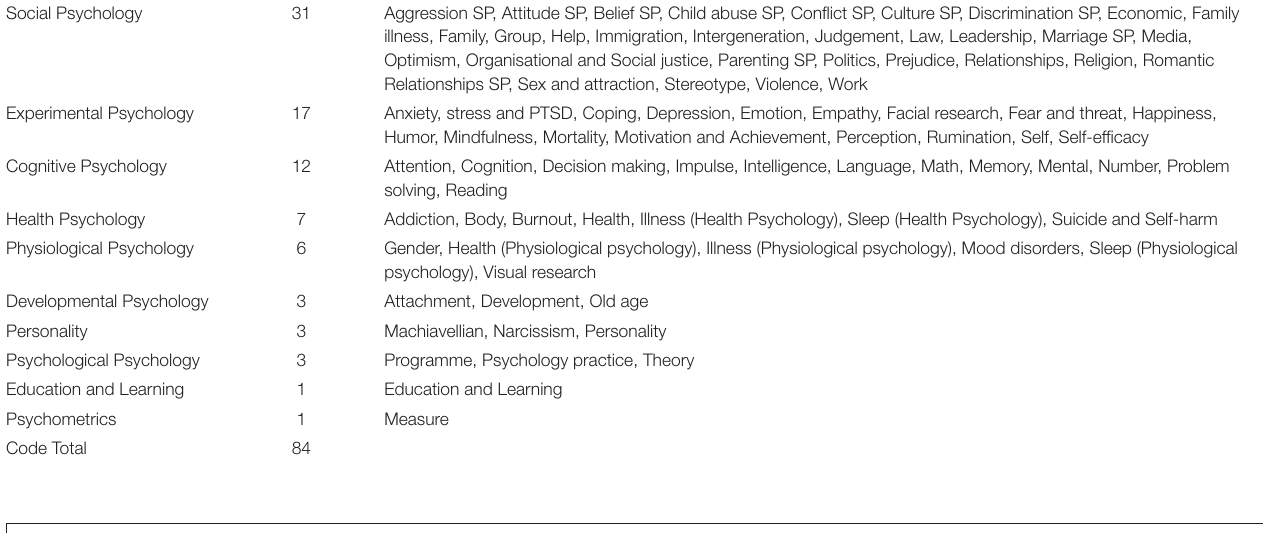
TABLE 1 | Codes used to form themes (research topics).